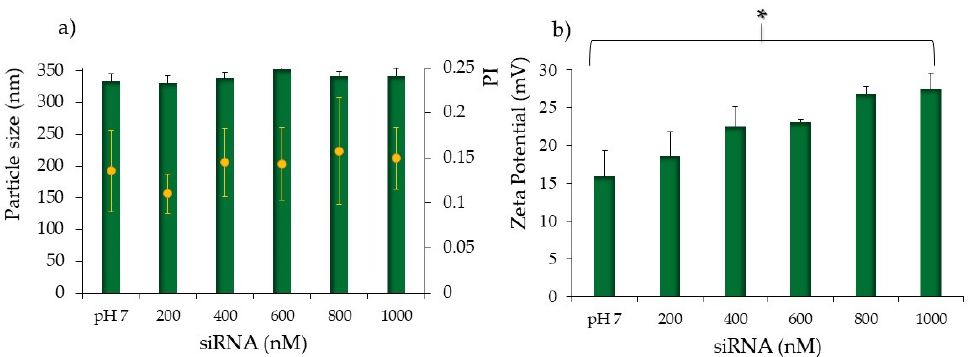
Figure 1. Average particle size (nm, blue bars), and Polidispersion Index (PI, orange dots). ( a ) Zeta potential values ( b ) for the CS-OA NPs in pH7 buffer (control, without siRNA loading) and after the addition of siRNA from 200 to 1000 nM. Analysis of variance (one-way ANOVA) and multiple range test (MRT) ( p < 0.05); mean values ± s.d., n = 5. * indicates statistical significance.